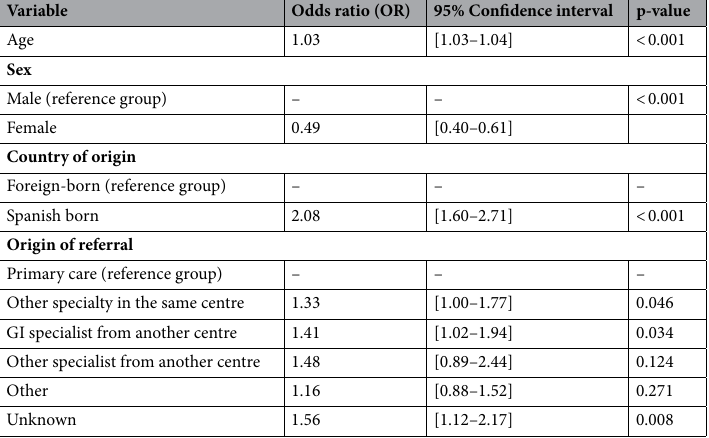
Table 6. Odds ratios and their 95% confidence intervals univariate logistic regressions for late presentation. GI